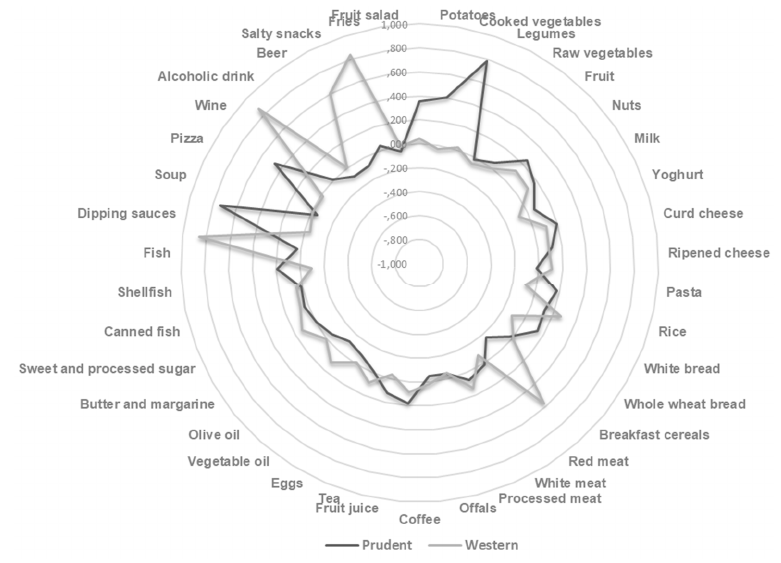
Figure 1. Radar graph of factor loadings that characterize each dietary pattern. Table 2. Characteristics of women from the “Mamma & Bambino” cohort ( n = 232) according to adherence to the Western dietary pattern.